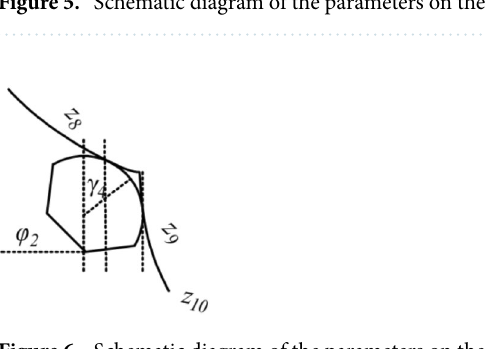
Figure 6. Schematic diagram of the parameters on the right splay